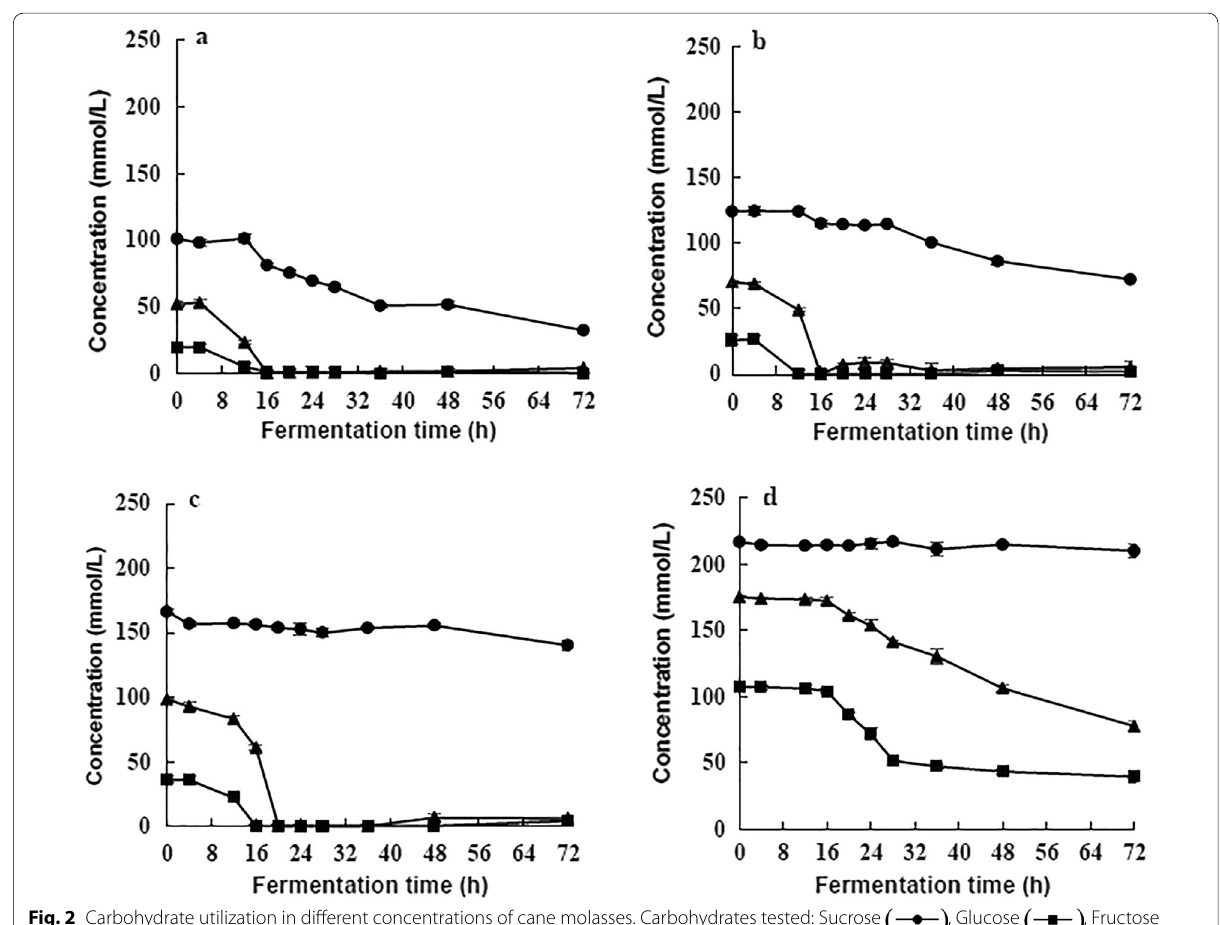
Fig. 2 Carbohydrate utilization in different concentrations of cane molasses. Carbohydrates tested: Sucrose